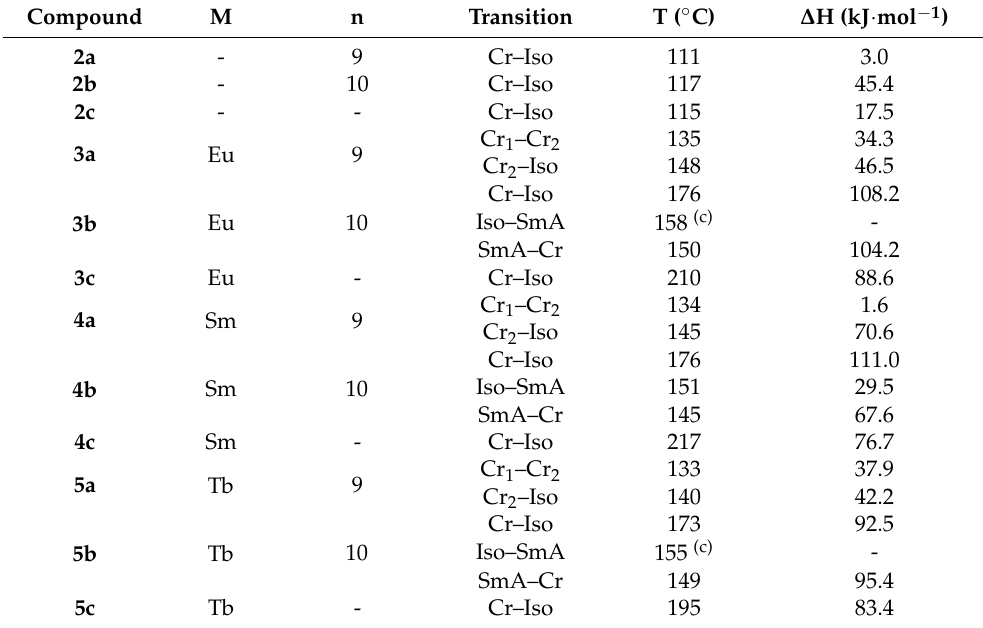
Table 3. Thermal parameters (a) (transition temperatures in ◦ C and the enthalpies (b) in kJ · mol − 1 ) of the organic ligands and their lanthanide (III) complexes.